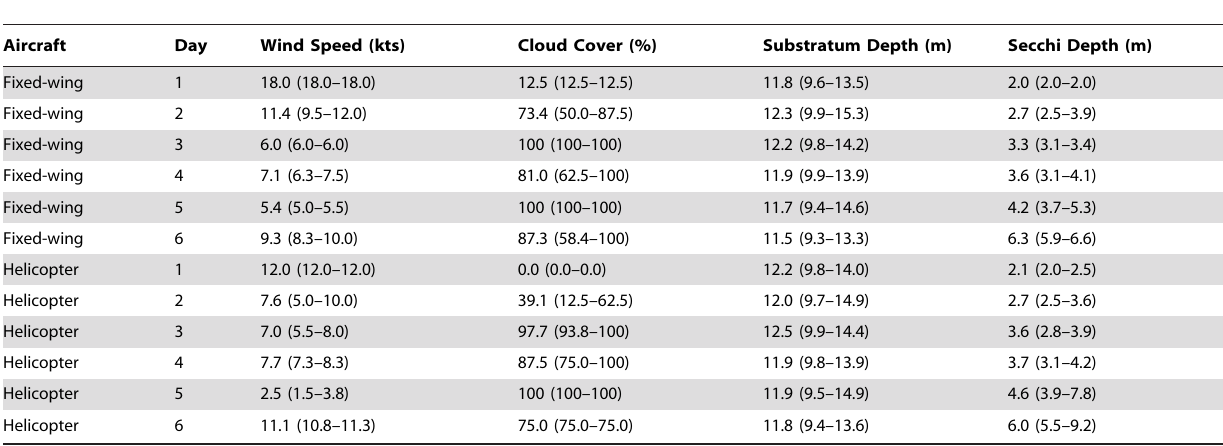
Values indicate mean for the day, numbers in parenthesis indicate range. doi:10.1371/journal.pone.0083456.t003 PLOS ONE |